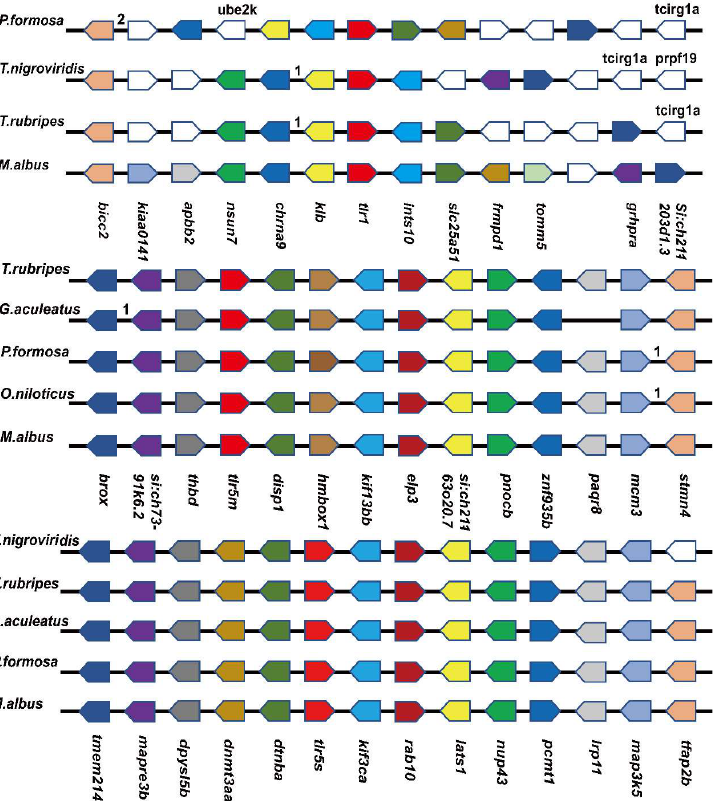
Figure 3. Genes marked in red are the target genes, and the direction of the arrow is the transcription direction. The number indicates the number of genes hidden between the two genes. White genes indicate genes that are different from the annotated genes. The name of the gene is given at the top. If it is not given, it is unnamed.